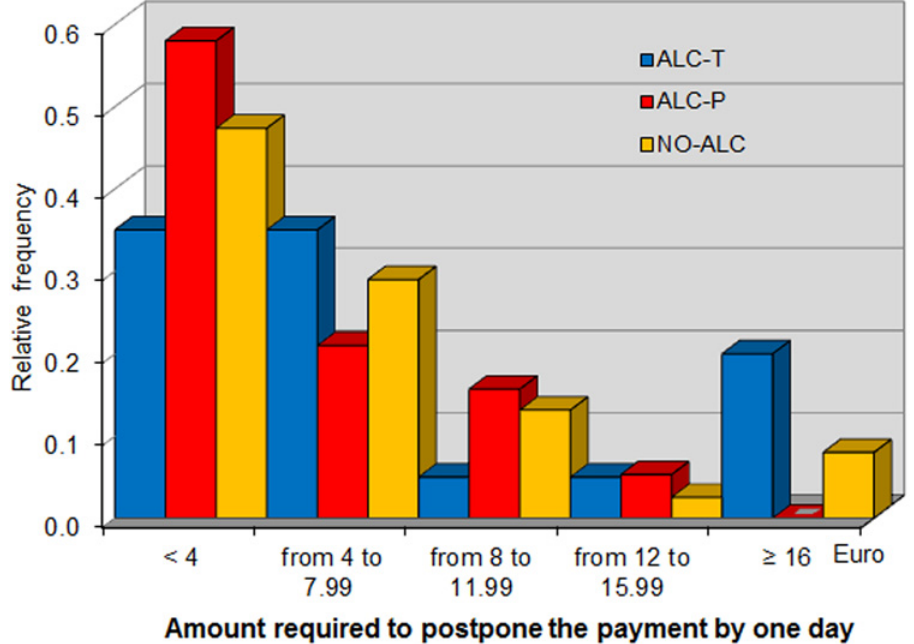
Fig 5. Distribution of additional sum required to postpone payment by one day.